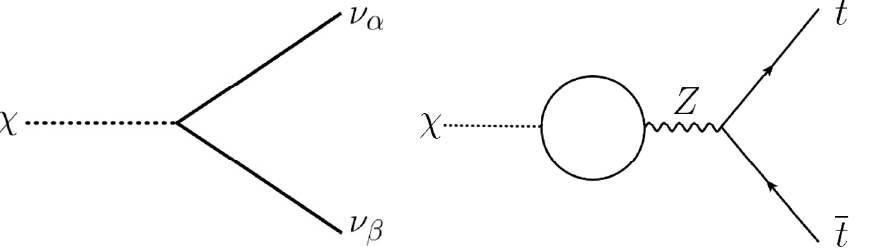
Figure 1 . The Feynman diagrams for the DM decay processes. (left): (cid:31) ! (cid:23) (cid:11) (cid:23) (cid:12) . (right): (cid:31) ! tt . The internal lines in the loop represent the active and heavy